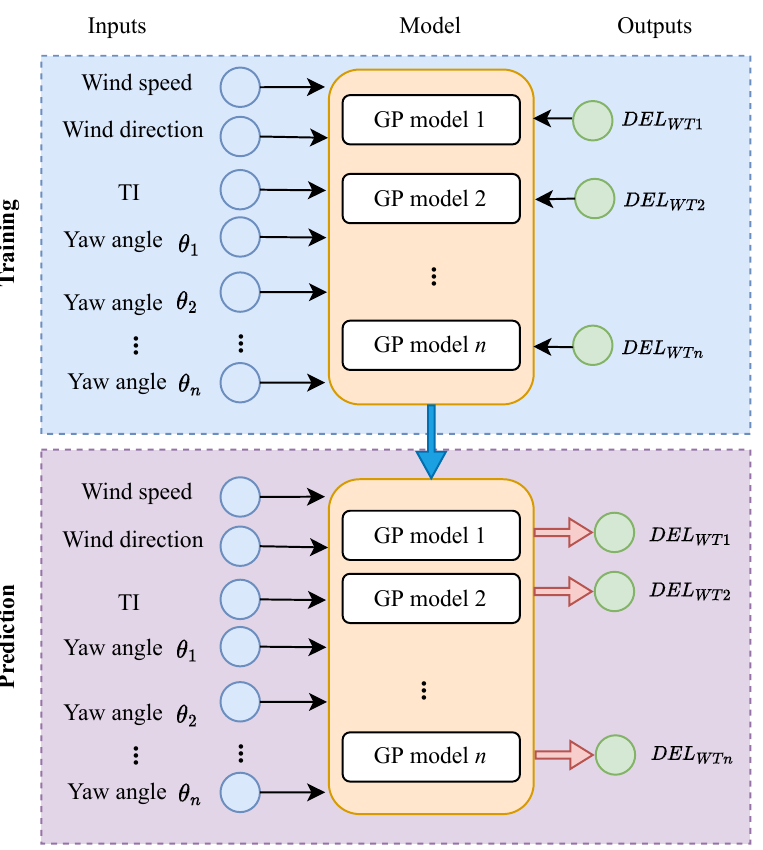
Figure 4. GP prediction